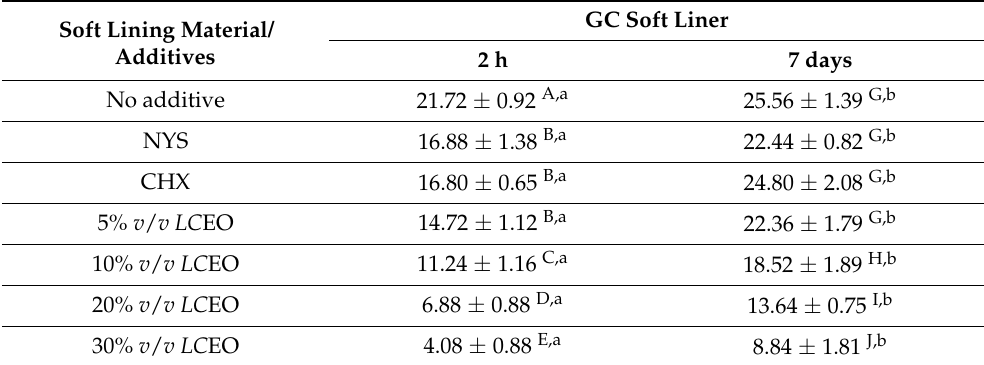
Table 6. Shore AO hardness values of GC soft liner with and without additives are shown as mean ± SD ( n = 5). Same uppercase superscript letters denote no significant difference ( p > 0.05) among additives only within the same column. Same lowercase superscript letters denote no significant difference between 2 h and 7 days ( p >